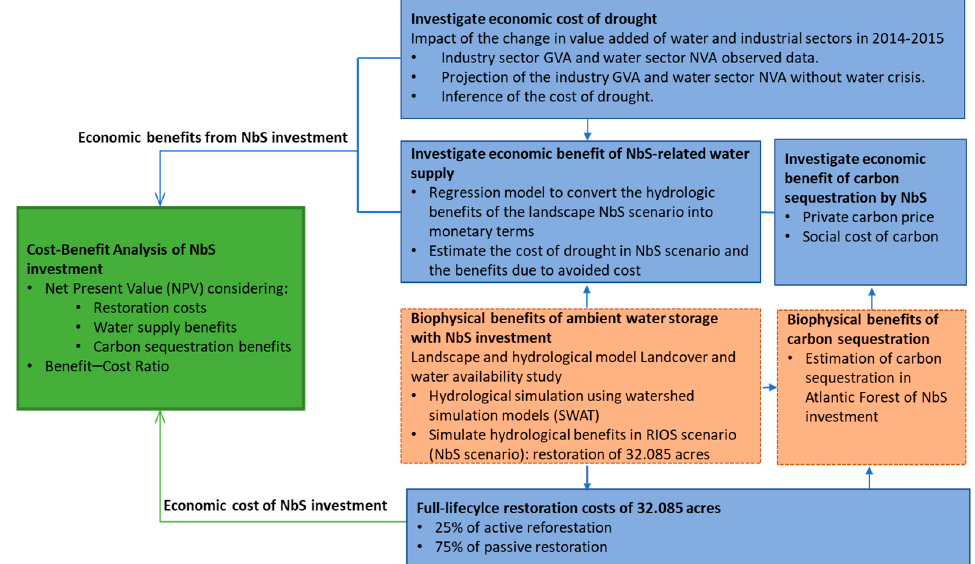
Figure 2. Steps to develop the cost–benefit analysis of NbS investment in Cantareira water supply system.